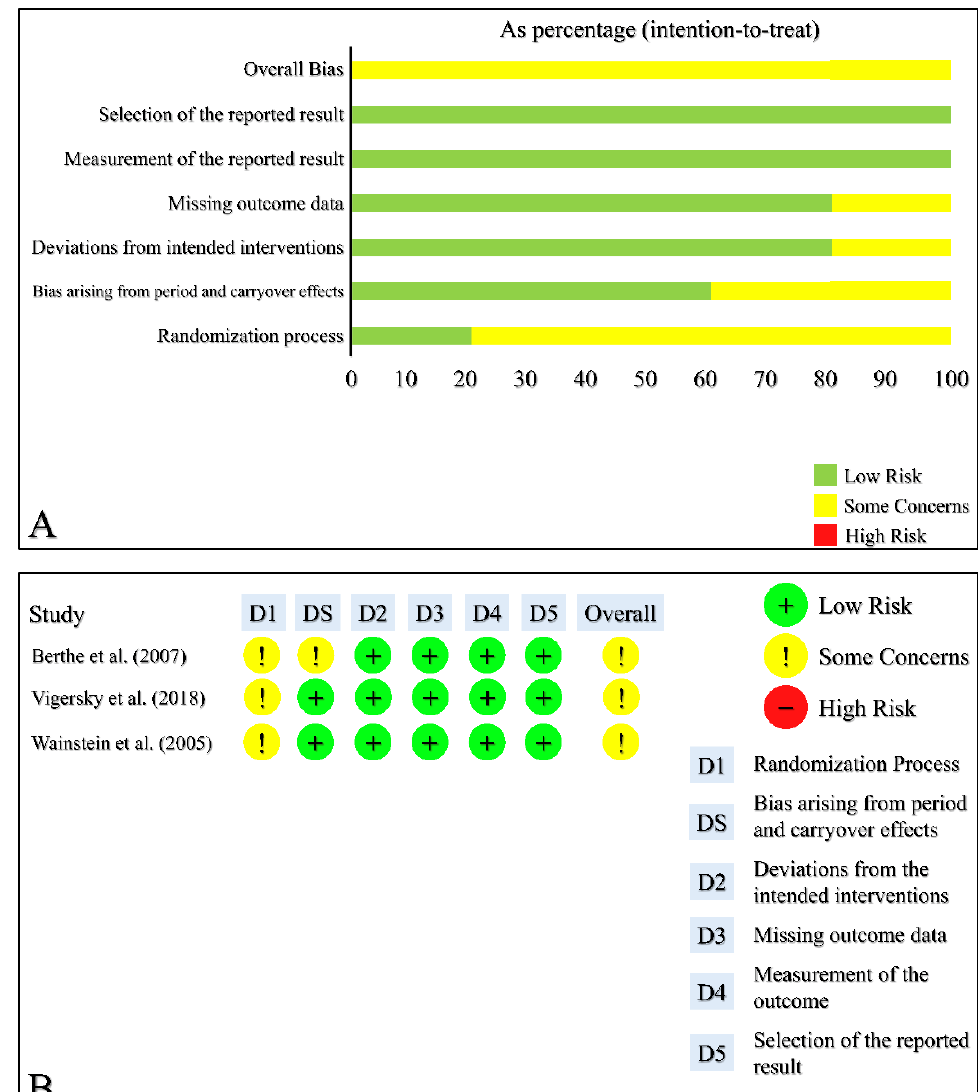
Figure 2. Risk of Bias Assessment Traffic Light Illustration for Studies with Parallel Design.